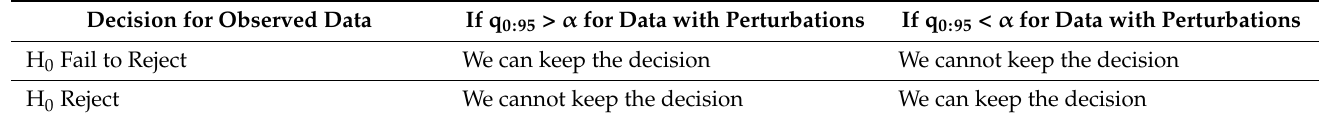
Table 1. Criteria to validate decision regarding BL